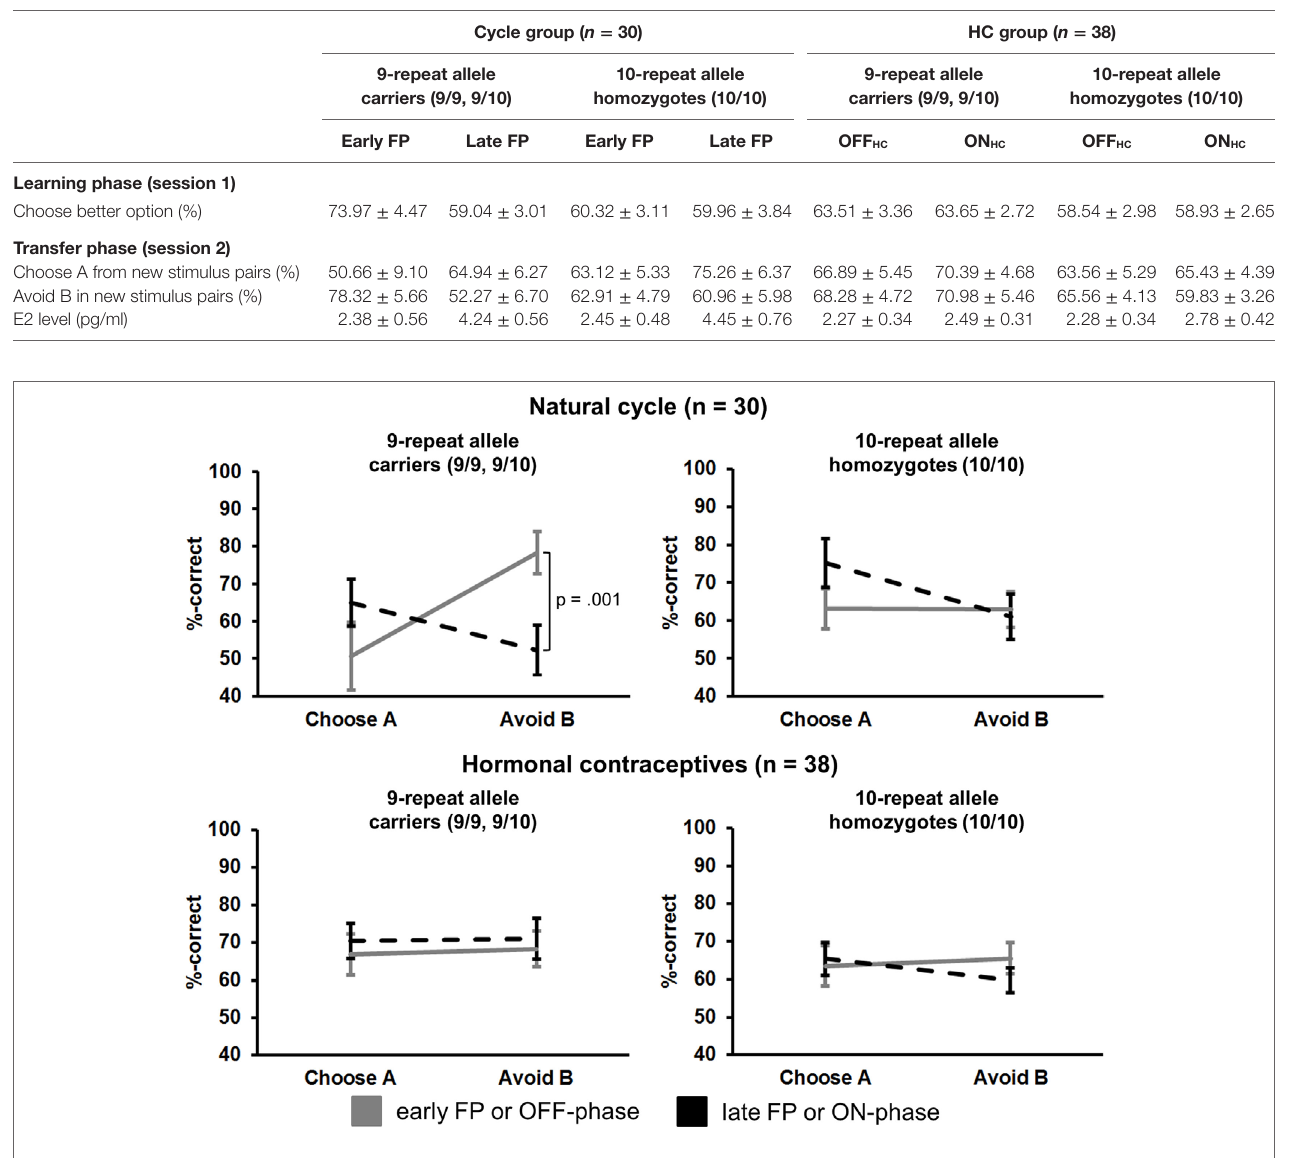
FigUre 1 | Interaction of “ phase ” × “ preference ” × “ study group ” × “ DAT1-genotype” in the transfer phase (session 2). Carriers of the 9RP in the cycle group experienced a significant decline in the ability to avoid punishment from the early to the late FP (top left graph). Neither the 10H from the cycle group nor 9RP carriers or 10H from the HC group showed this difference between phases.